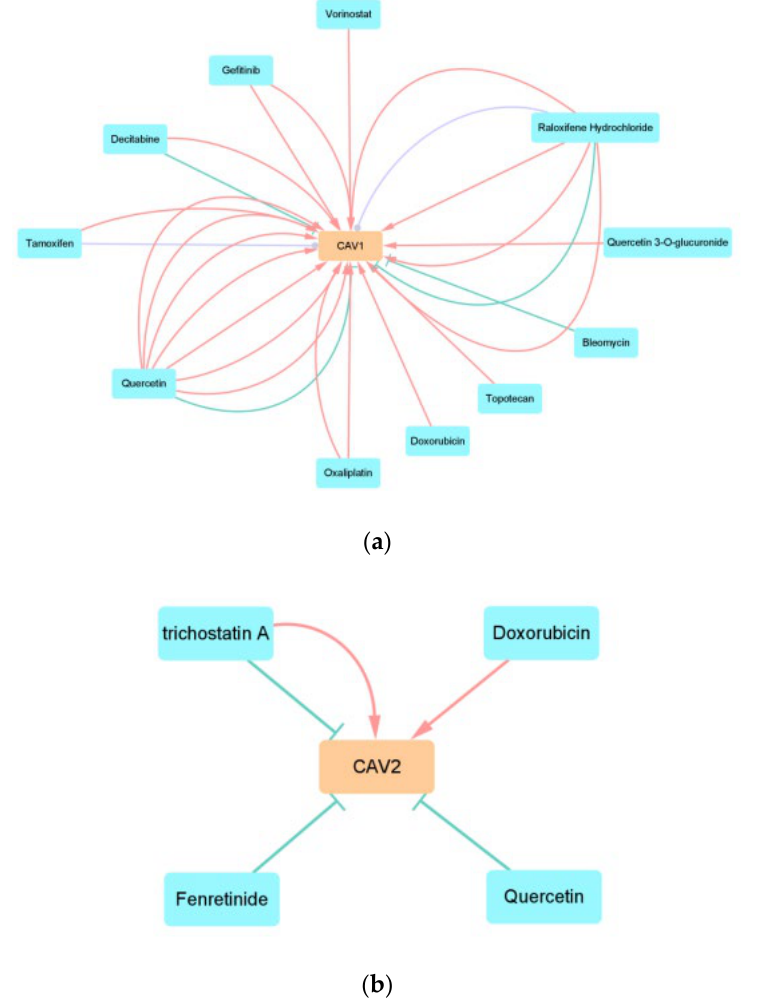
Figure 10. We construct the CAV–drug interaction network with the two genes and anticancer drugs. ( a , b ) T represents that the drug can decrease the expression of the gene, delta represents that the drug can increase the expression of the gene, and the circle represents that the drug can affect the expression of the gene. The number of lines represents the number of previous studies.